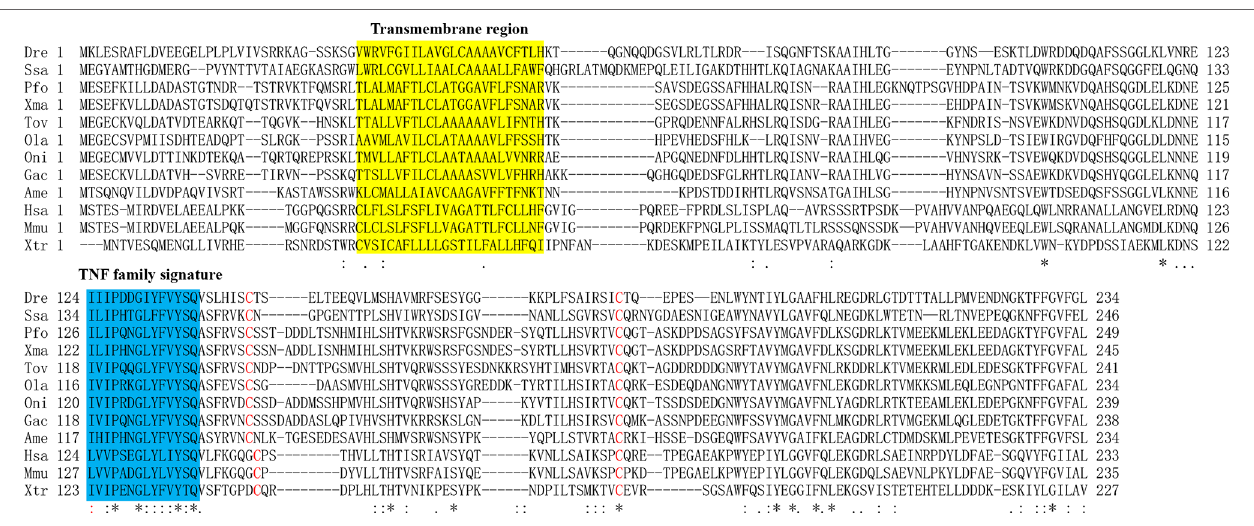
FIGURE 2 | Alignments of TNF α amino acid sequences from different species. The TNF signature motif is shown in the blue box. The transmembrane region is shown in the yellow box. Cysteines conserved in TNF α are marked by red. Identical (asterisks) and similar (: or.) residues identified by the CLUSTAL W program are indicated. The Latin abbreviation and accession numbers are listed in Table S1 .